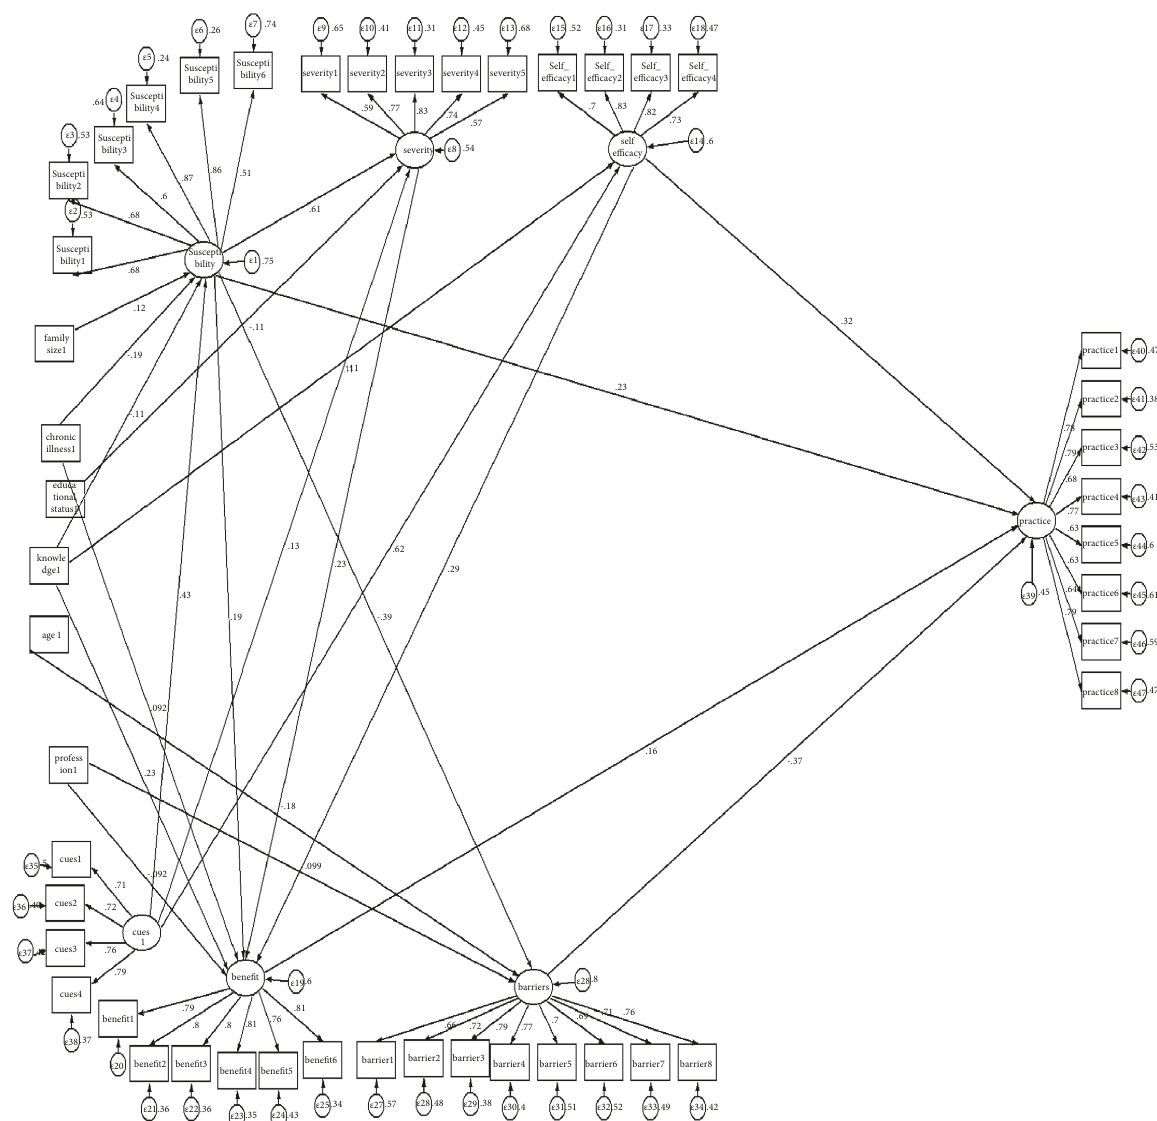
Figure 1: Structural equations modeling with standardized coefficients of COVID-19 prevention practice among academic staff of University of Gondar, Ethiopia, 2021, using the health belief model. Note . Statistically insignificant paths between variables are not